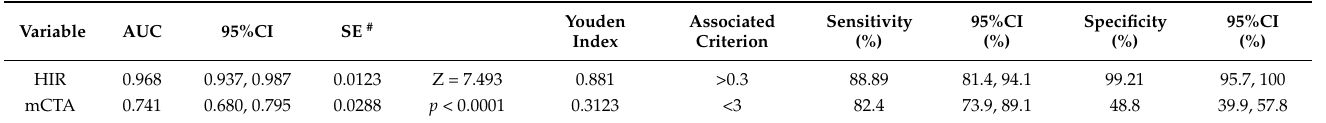
Table 3. Criterion Values and Coordinates of ROC Analysis Regarding Functional